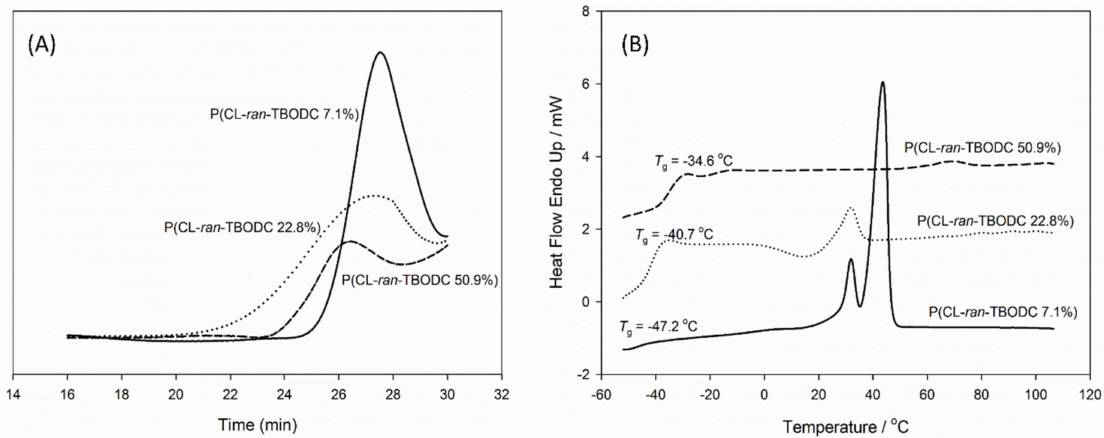
Figure 2. ( A ) Gel permeation chromatography (GPC) curves of P(CL- ran -TBODC), ( B ) second heating scan of DSC traces of P(CL- ran